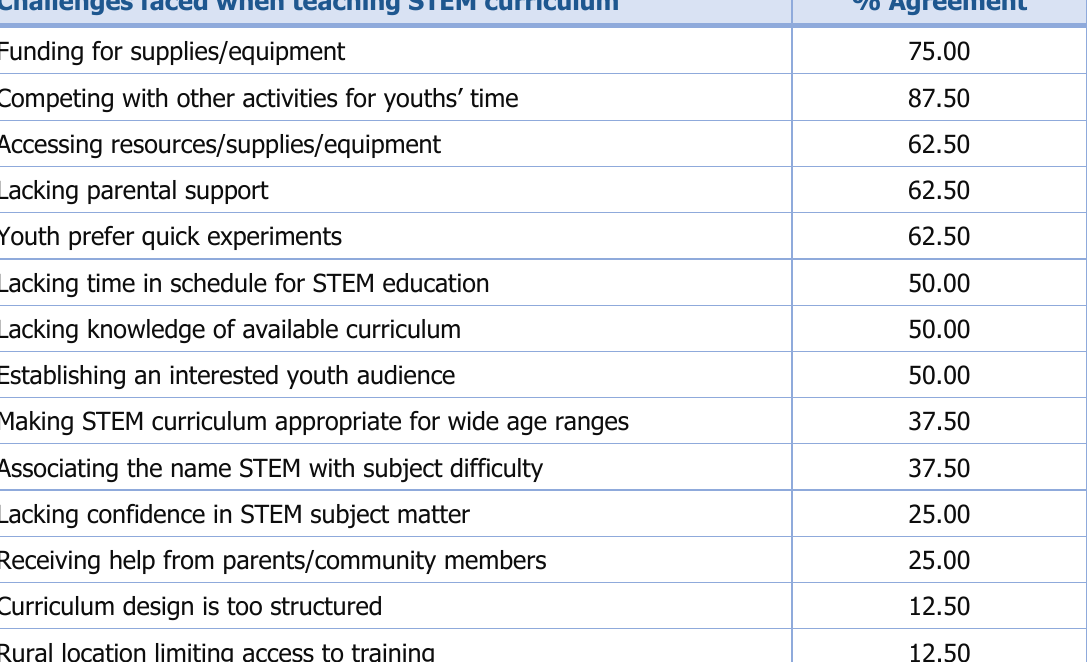
Table 1. Challenges Statements and Agreement Percentages in Round 2: Volunteer Panel (N =